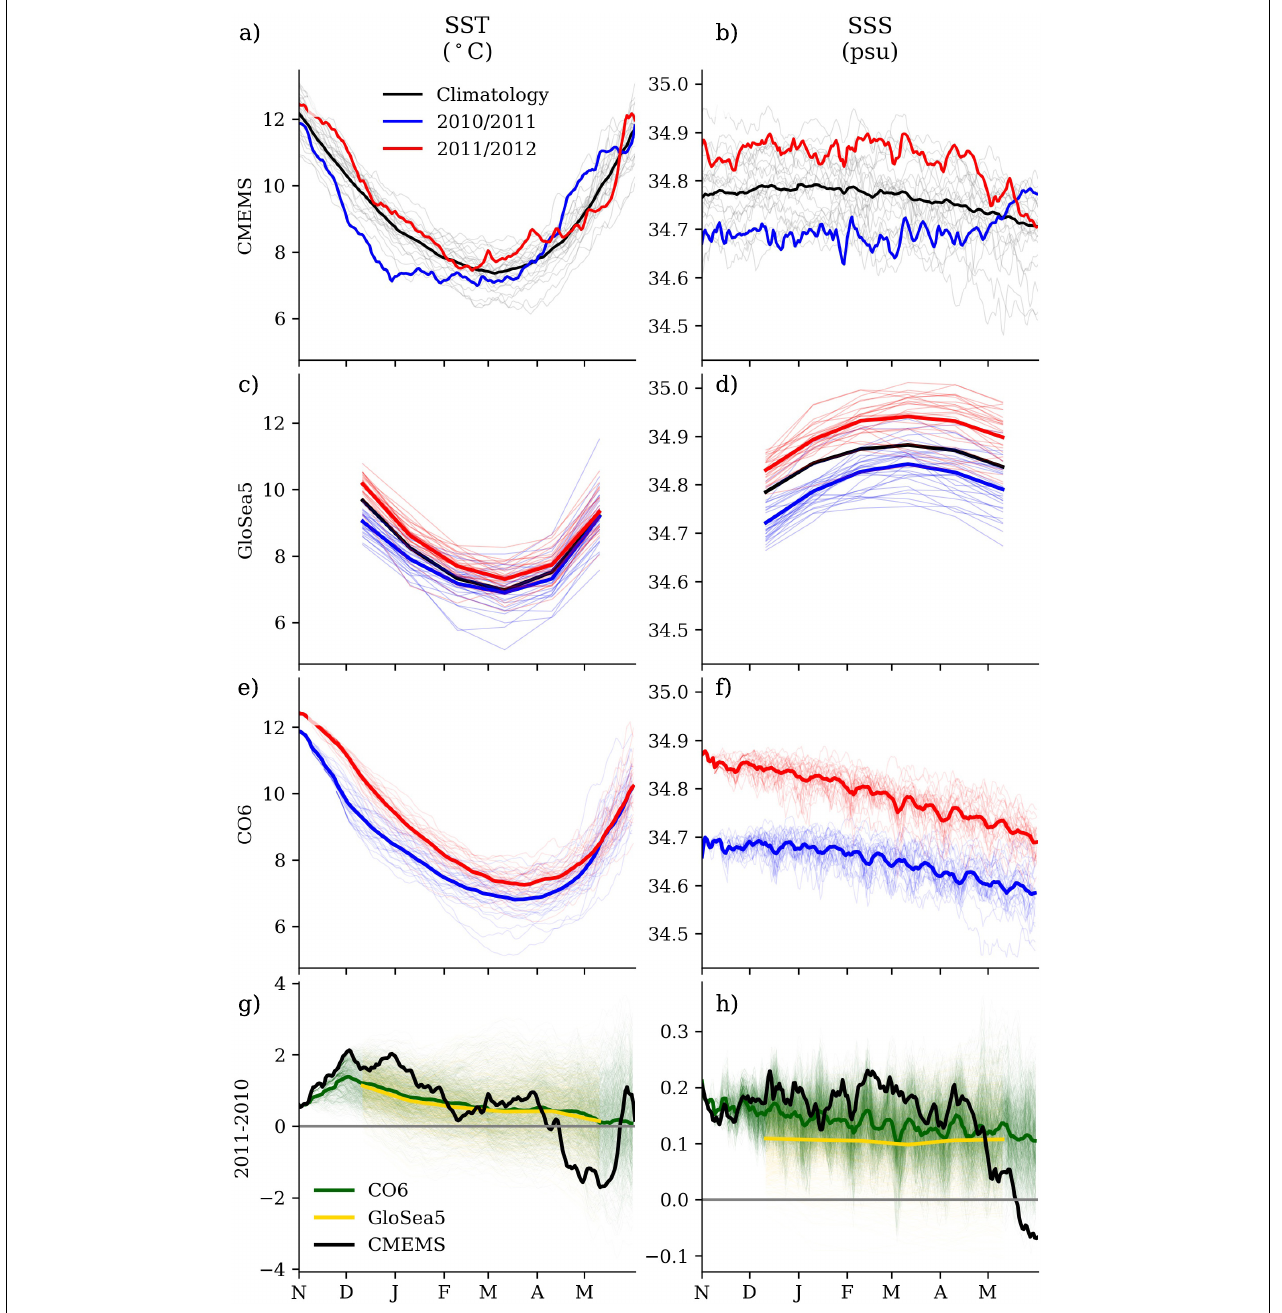
FIGURE 9 | Comparison of the temporal evolution of the 2010/2011 (blue) and 2011/2012 (red) winters for the NWS SST (a,c,e,g) and SSS (b,d,f,h) . (a,b) : CMEMS: thin black lines, individual years between 1994 and 2016, with the mean year (climatology) shown in bold black. 2010/2011 and 2011/2012 are shown in blue and red respectively. Where a coloured line is above the climatology (bold black), a positive anomaly for that year was “observed.” (c,d) : GloSea5 forecasts. Bold black line is model climatology – the average of the ensemble mean forecasts for each year. 2010/2011 and 2011/2012 are shown in blue and red respectively. Thin lines are the individual ensemble member for each forecast year. The bold coloured lines are the ensemble mean GloSea5 forecast. (e,f) : CO6 forecasts. Same as for row 2, except there is no climatological seasonal cycle available. The lower row (g,h) is the differences between the years – 2011/2012 - 2010/2011, i.e., how much warmer/saltier/higher 2011/2012 was than 2010/2011. Black line: the difference between CMEMS “observations.” The gold line is the difference between GloSea5 forecasts, and the dark green lines are the difference between the CO6 dynamically downscaled forecasts (ensemble mean in bold and ensemble member pairs as thick lines). Other regions are shown in the Supplementary Materials . NBT is given in Supplementary Figure 12 . The legend in (a) applies to (a–d) . The legend in (g) applies to (g,h)